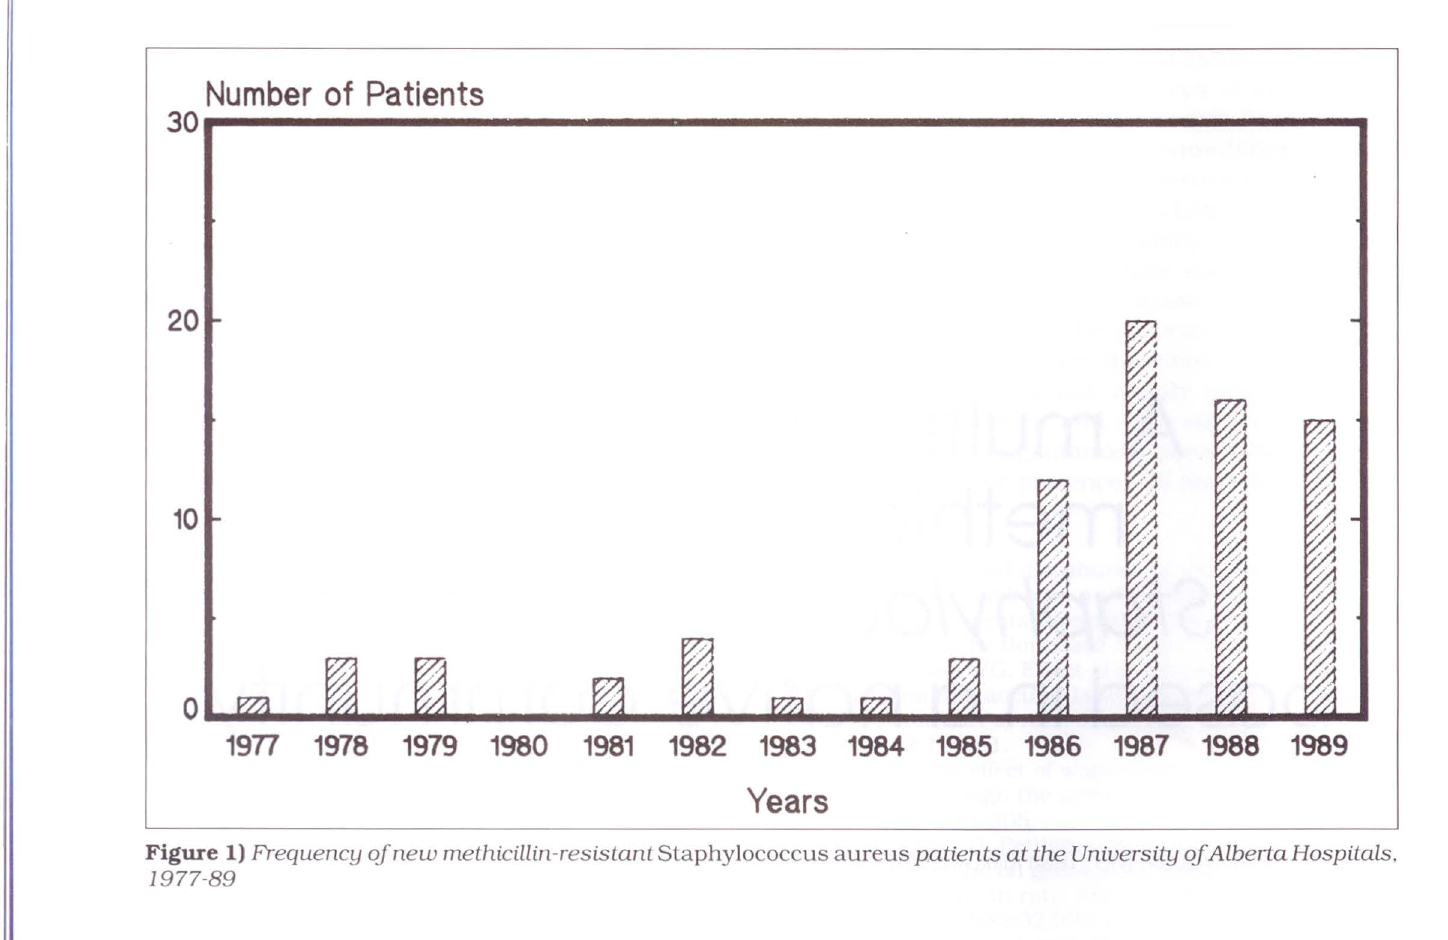
Figure 1) Frequency of new methicillin-resistant Staphylococcus aureus patients at the University of Alberta Hospitals, 1977-89